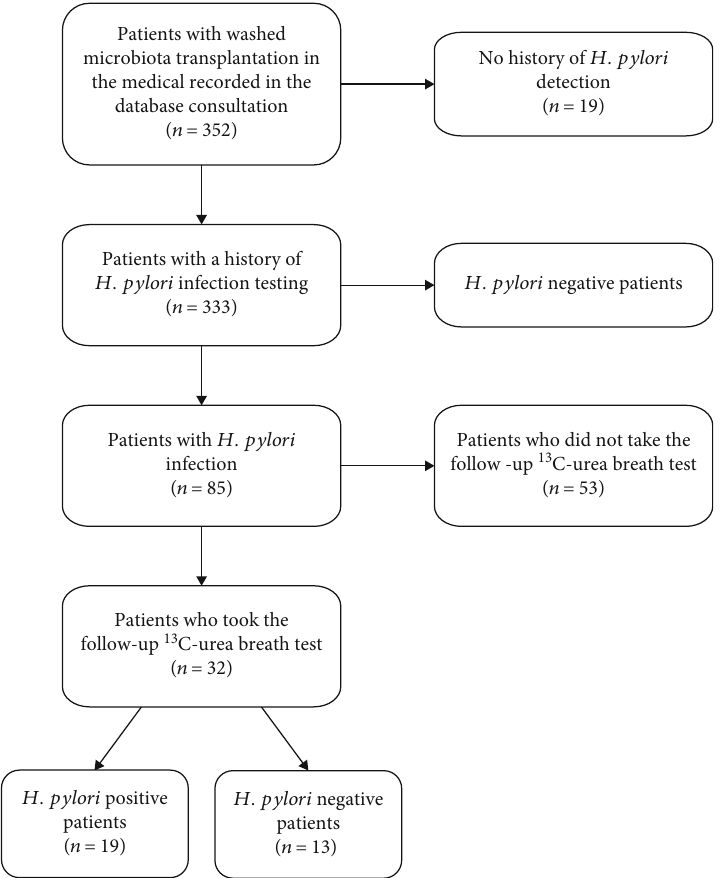
Figure 1: Flowchart for the inclusion of